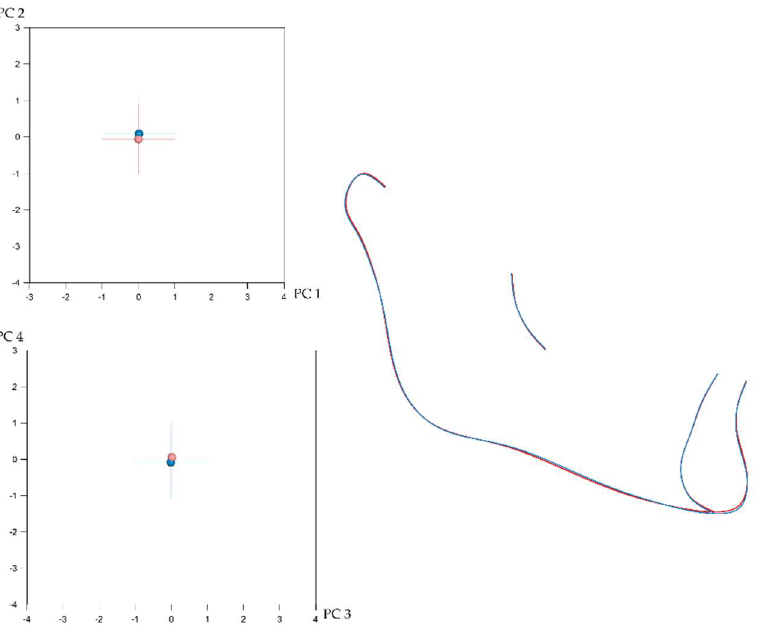
Figure 4. Left : Average difference between males (blue) and females (light red) in mandibular shape as explained by PC1 (24.9%)–PC2 (21.4%) ( top ) and PC3 (13.9%)–PC4 (11.3%) ( bottom ). The num- bers in the parentheses represent the percentage of variation explained by each PC. Right : Best fit superimposition of average male (blue) and average female (light red) mandibular configurations.